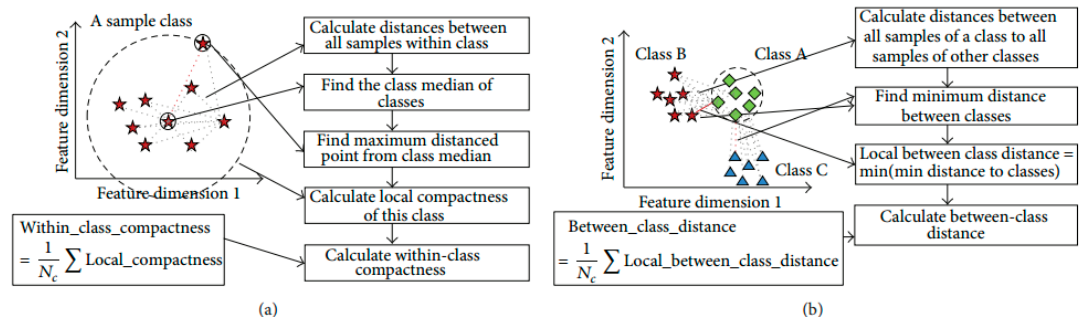
Figure 5. ( a ) Within-class compactness value and ( b ) between-class distance value calculation.